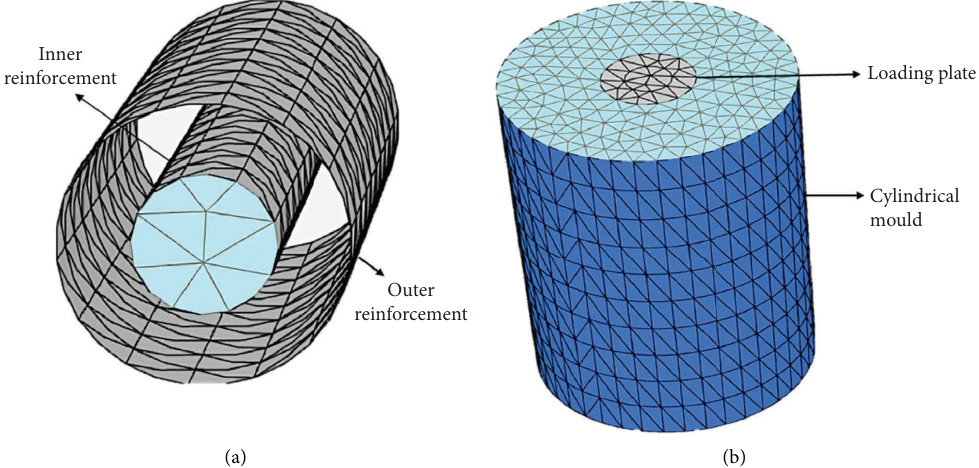
Figure 5: (a) Cross-sectional view of dual-layered encasement for a single stone column and (b) single-stone column